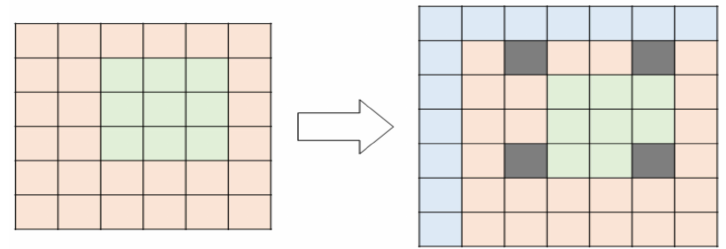
Figure 5. Calculation of the characteristic value of the integral